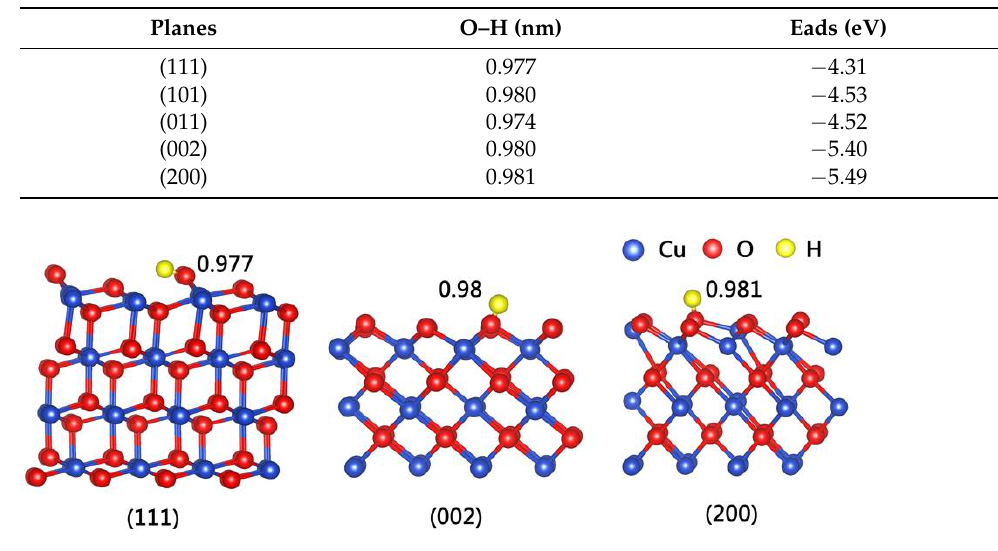
Figure 3. The geometric structures of H atom on various surfaces of CuO crystal. Table 1. The adsorption energy obtained using the first-principles calculation.